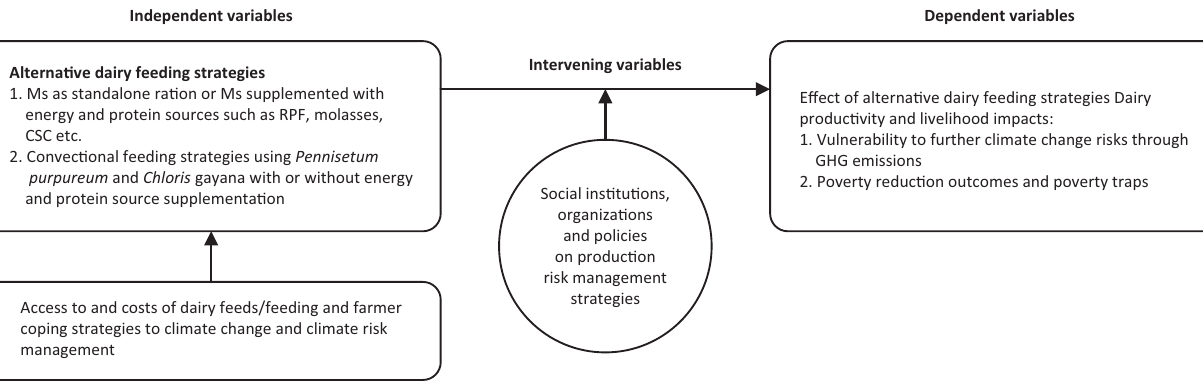
FIGURE 1: Conceptual